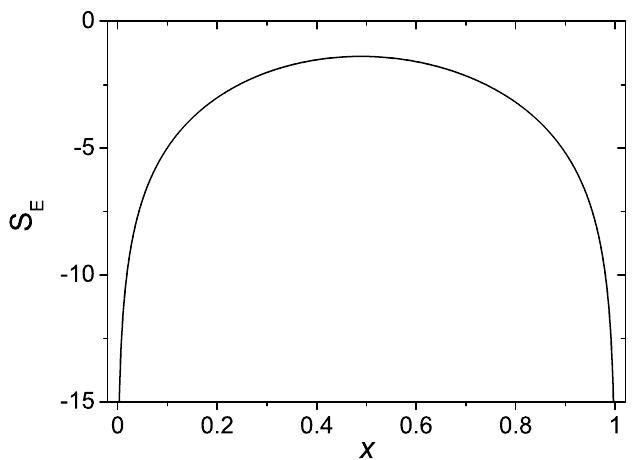
Figure 4. Entanglement entropy S E within the model with A = 10, B = 20, Q = 1.36 and u (cid:39) −